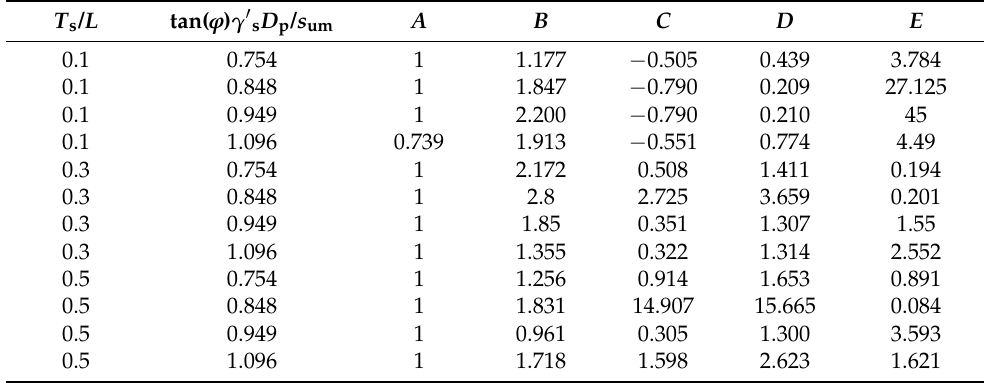
Figure 12. Typical FE results of the normalized bearing capacity in the V - H - M domain. Table 2. Values of A , B , C , D and E .